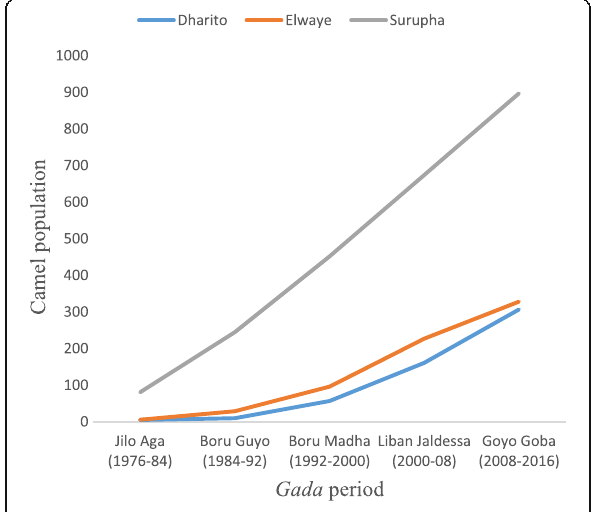
Fig. 6 Trend of camel population over the last five Gada periods owned by respondents in the three kebeles in the study area in Borana, southern